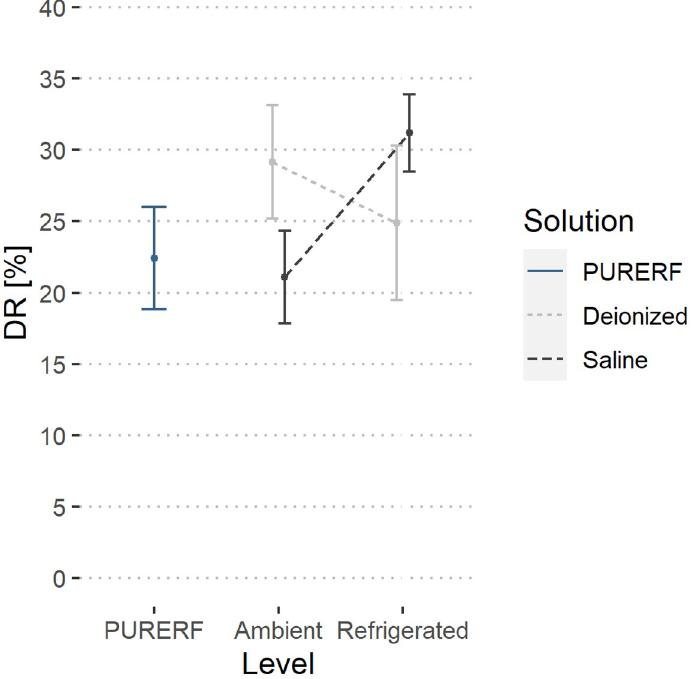
Fig 13. Estimated marginal averages of the DR indicator. The graph shows the interaction between the solution type and temperature. An inverse behavior between the solution type is observed with the change in temperature. The saline solution allows for a higher impedance drop compared to RFA.